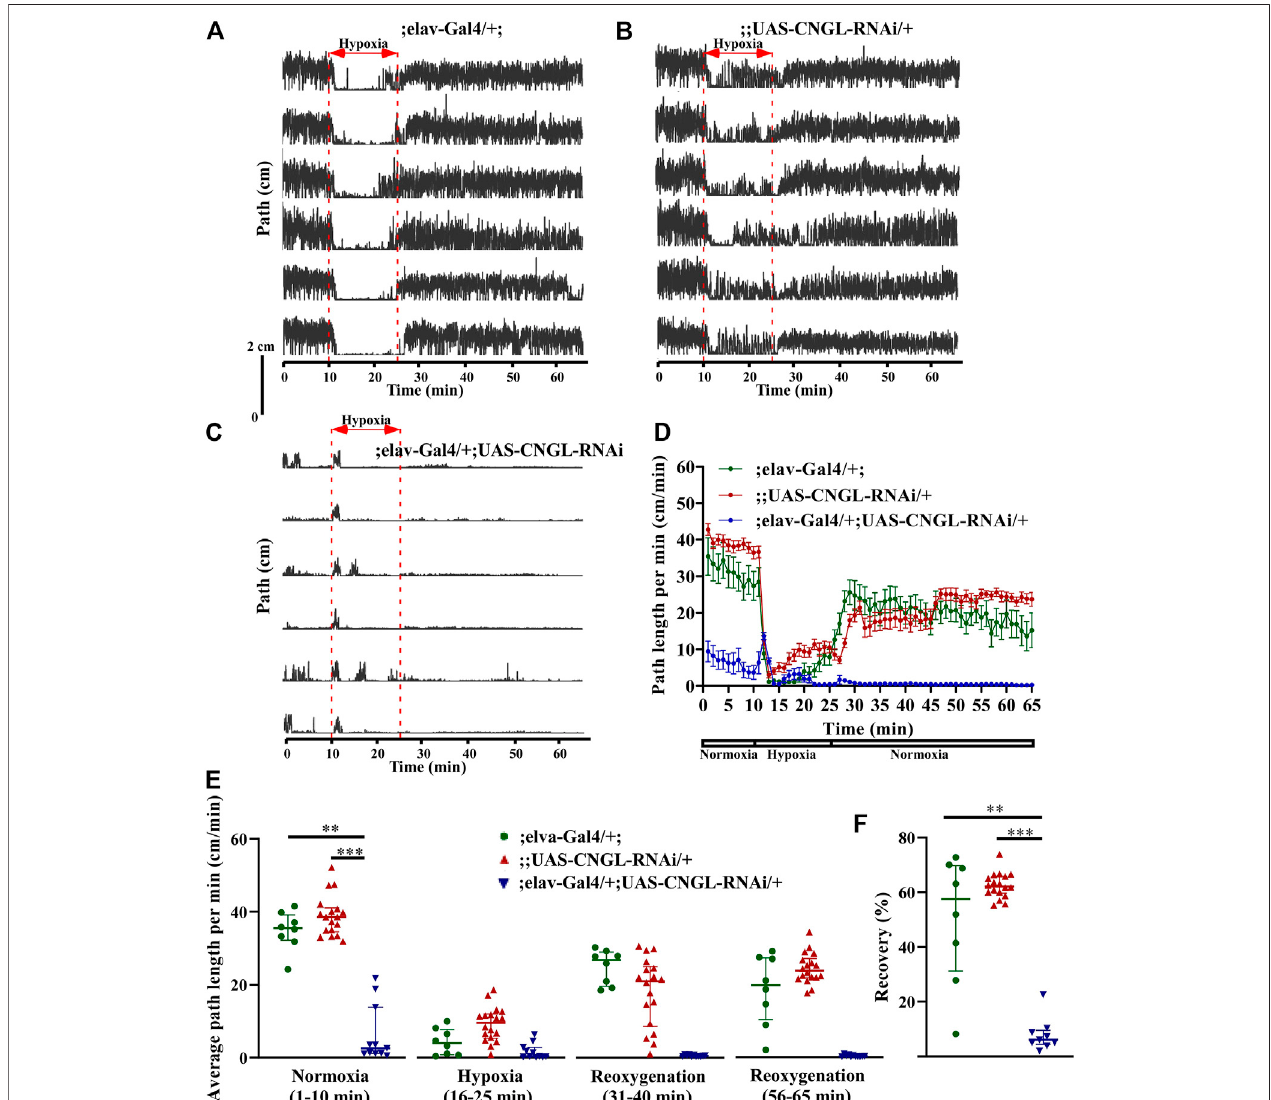
FIGURE3| Reducedlocomotoractivityundernormoxiaandreducedrecoveryinresponsetohypoxiain fl ieswith CNGL knockdowninneurons. (A – C) Locomotor analysis for fl ies with CNGL knockdown pan-neuronally and control fl ies with hypoxia. (D) Path length per minute of control fl ies (;elav-Gal4/+; , green circles and green line, n = 8, and ;UAS-CNGL-RNAi/+, red circles and red line, n = 18) and CNGL pan-neuronal knockdown fl ies (;elav-Gal4/+; UAS-CNGL-RNAi/+, blue circles and blue line, n = 11) during normoxia, hypoxia and recovery process. (E) The average path length per minute under normoxia (1 – 10 min), during hypoxia (16 – 25 min), and duringreoxygenation(31 – 40minand56 – 65 min)ofcontrol fl iesand fl ieswith CNGL knockdowninneurons. (F) Thepercentrecoveryofcontroland CNGL pan-neuronal knockdown fl ies. Asterisks (** or ***) indicate p < 0.01 or 0.001, respectively, by Kruskal – Wallis test with Dunn ’ s multiple comparison.